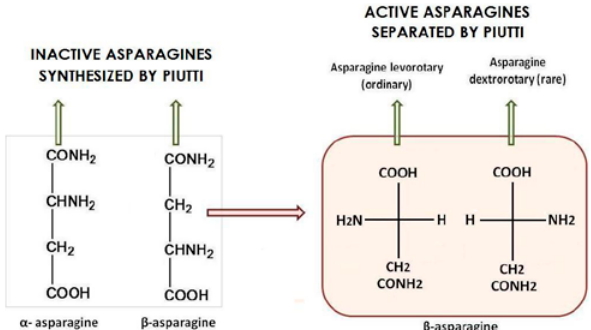
Figure 4. Nomenclature given by Piutti to the